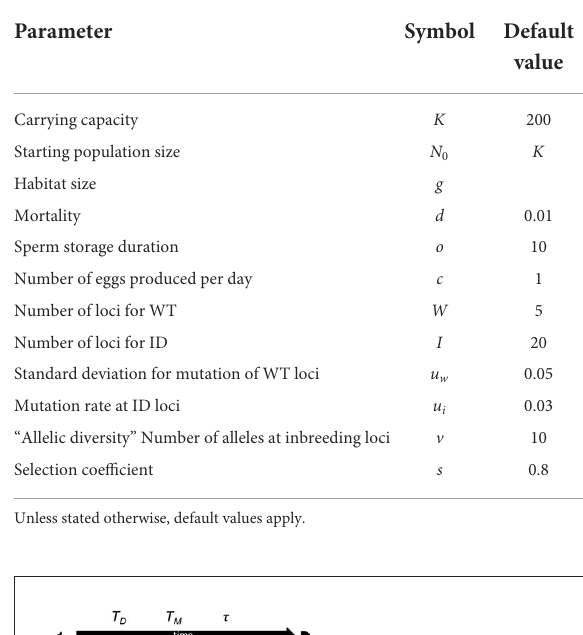
TABLE 1 Parameters and their values used for the model.